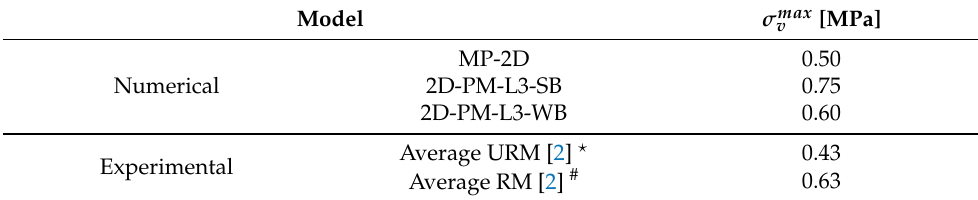
Table 5. Experimental and numerical values of the peak